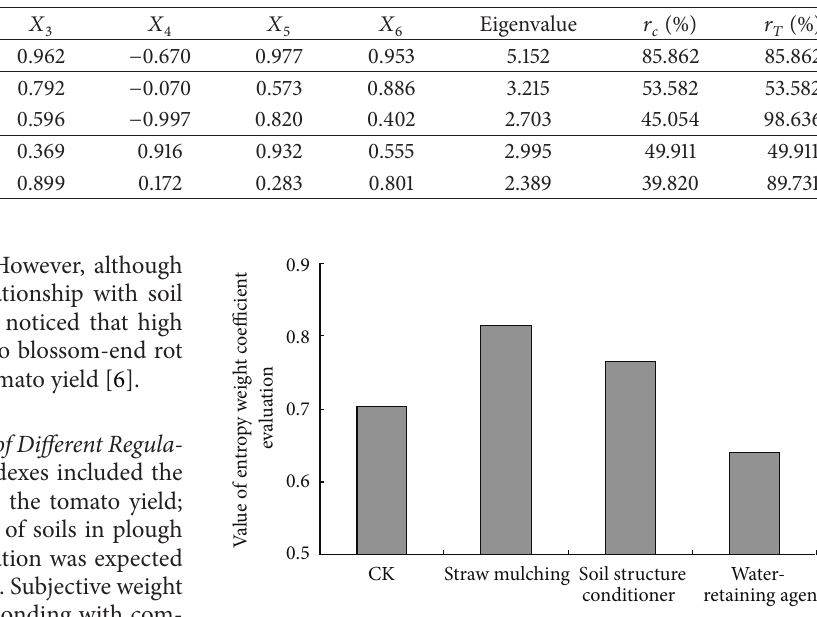
Table 4: Weight coefficient and contribution rate of main ingredients.